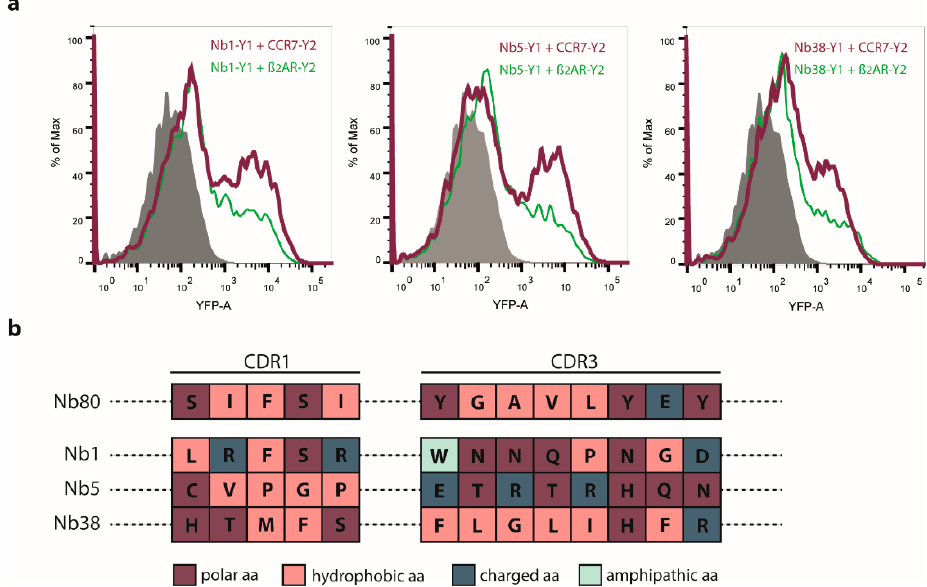
Figure 2. Flow cytometric analysis ( a ) and sequence analysis ( b ) of individual Nb clones previously selected by BiFC screening. ( a ) Plasmids coding for Nb-YFP1 (Y1) were isolated and individual clones were co-transfected again with CCR7-YFP2 (Y2) to screen for single Nb clones that recognize CCR7. Here, the three most promising Nb clones are represented: Nb1, Nb5, and Nb38. BiFC between individual Nb clones and CCR7 is indicated in red. Additionally, BiFC of individual Nb-YFP1 clones and β 2 AR-YFP2 was analyzed and is depicted in green. ( b ) Nb1, Nb5, and Nb38 were sequenced. Protein sequences of CDR1 and CDR3 of each Nb are illustrated in comparison to Nb80. Di ff erent colors were used to highlight characteristic properties of respective amino acids (aa).